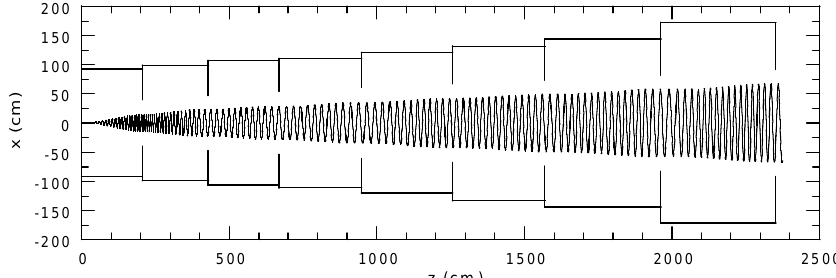
FIG. 3. Projection onto the x - z plane of the orbit of a typical proton. Outlines of the cavities are also shown. Since the orbit radii are considerably smaller than the cavity radii, the opportunity exists to insert radial vanes that will result in smaller outer radii for the cavities while preserving adequate apertures for the